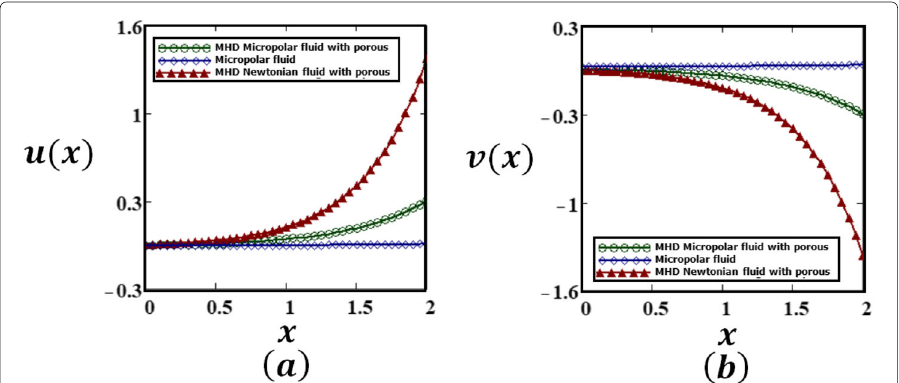
Fig. 10 Profiles of the velocity field u ( x , t ) and v ( x , t ) for MHD micropolar fluid with porous effect, micropolar fluid, and MHD Newtonian fluids with porous given by Eqs. (32), (33), and (34), for U = 0.1, ν = 0.045, μ = 0.5, κ = 0.2, B 0 = 0.2, k ∗ = 0.2, σ = 0.2, j = 0.03, m = n = 1, y = 1, c 0 = 0.01, and t = 2